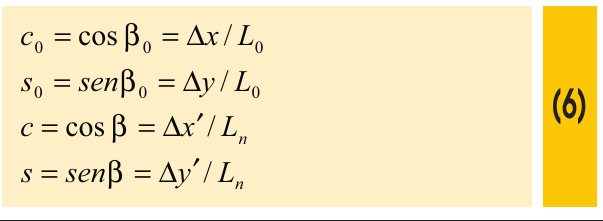
Figure 2 – Degrees of freedom and internal forces of the local